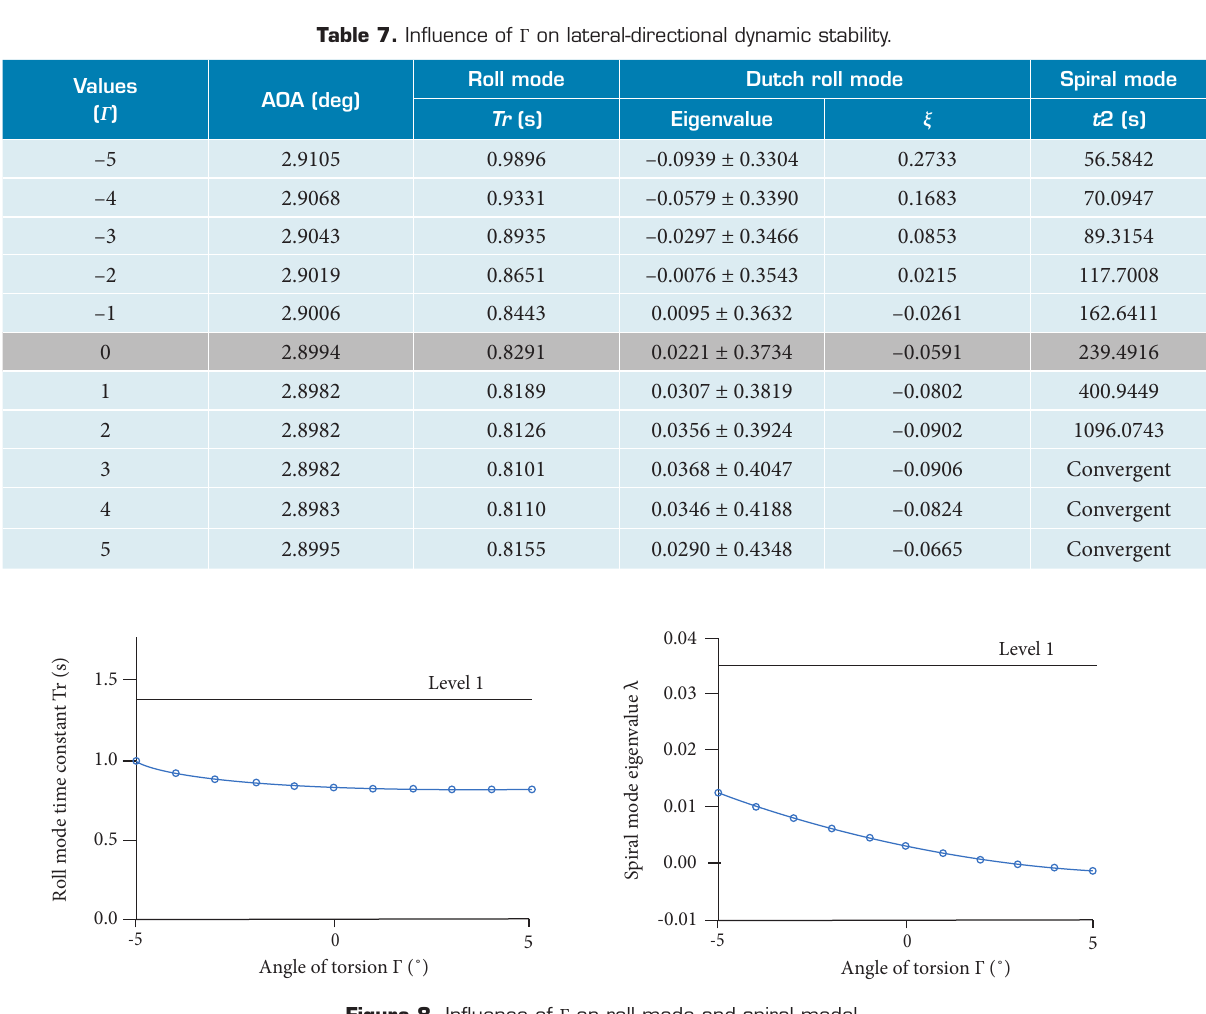
Figure 8. Influence of Γ on roll mode and spiral